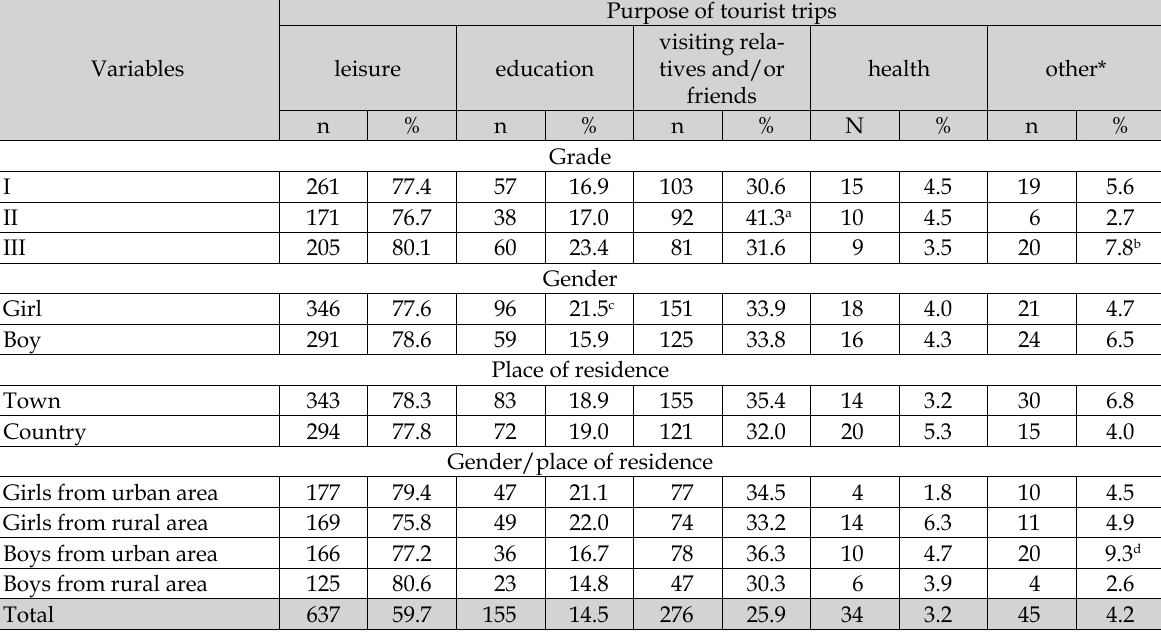
Table 2. Purposes of respondents tourist trips in socio-demographic context.